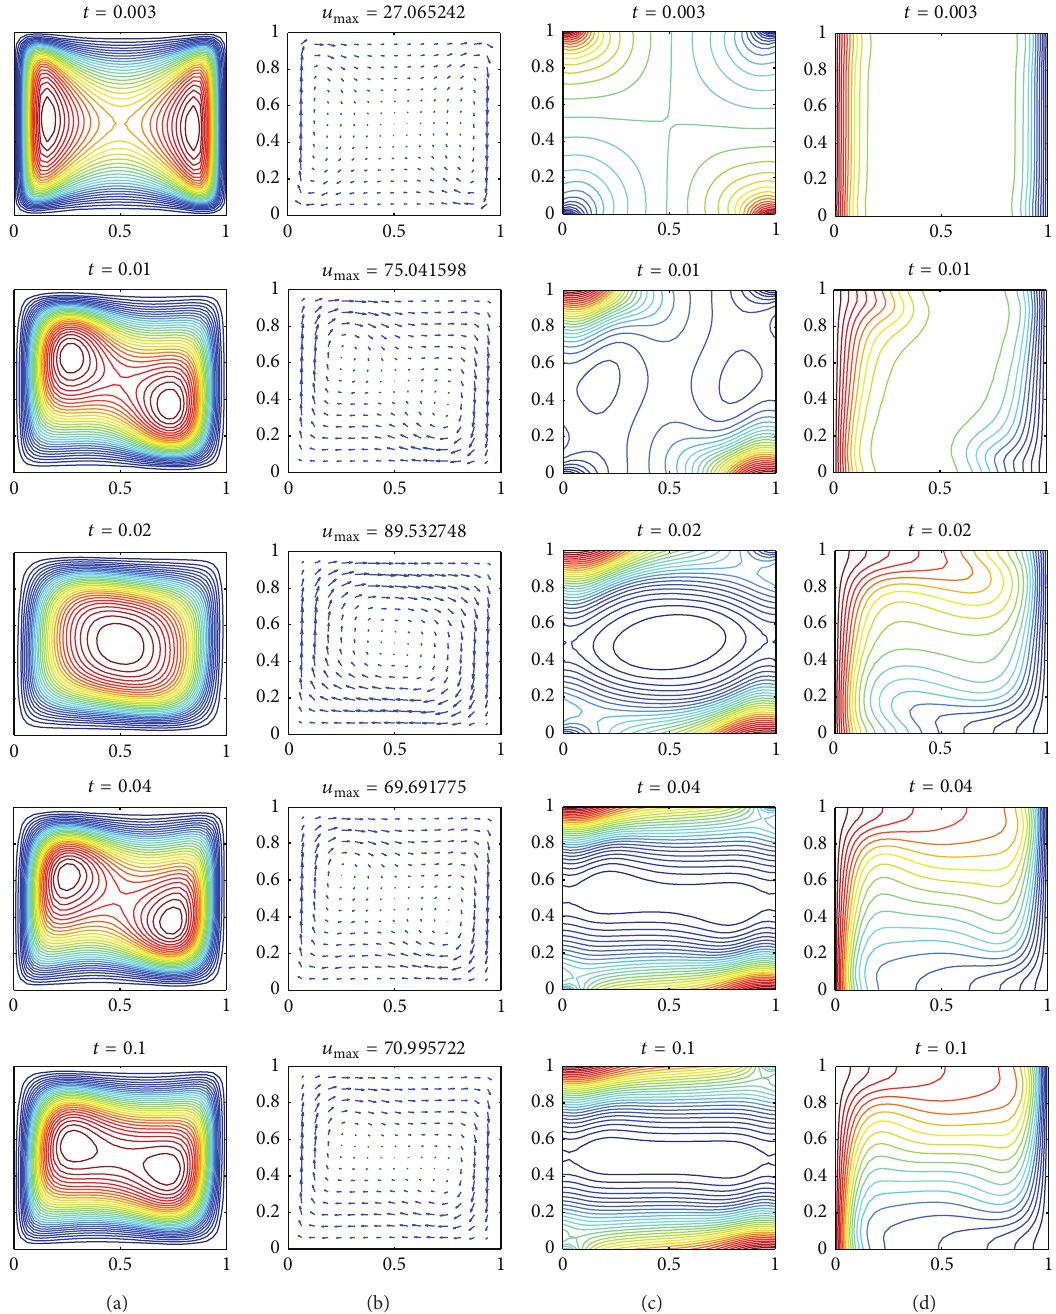
Figure 6: Example 21: time sequence 𝑡 = 0.003 , 0.01 , 0.02 , 0.04 , and 0.1 for the driven cavity. The first two columns are the streamlines and vector fields for velocity, and the third and fourth ones are the contour lines for pressure and temperature, respectively. The nondimensional parameters are 𝜅 = 10 5 ,𝜆 = 1 , and 𝜇 = 1 , and the discretization parameters are 𝜏 = 10 −4 , ℎ = 2 −5 . Note that 𝑢 max stands for ‖ u ‖ ∞